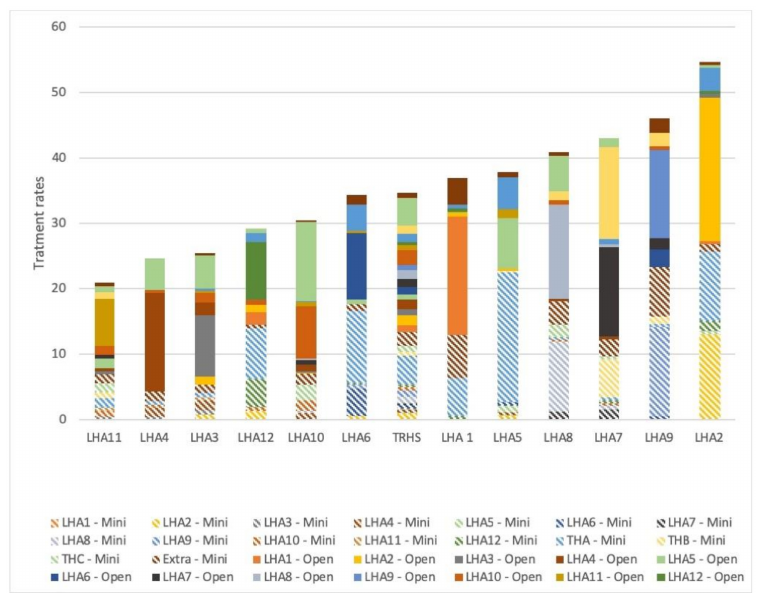
Figure 5. Benign hysterectomy treatment rates for the 12 LHAs, stratified by provider and surgical